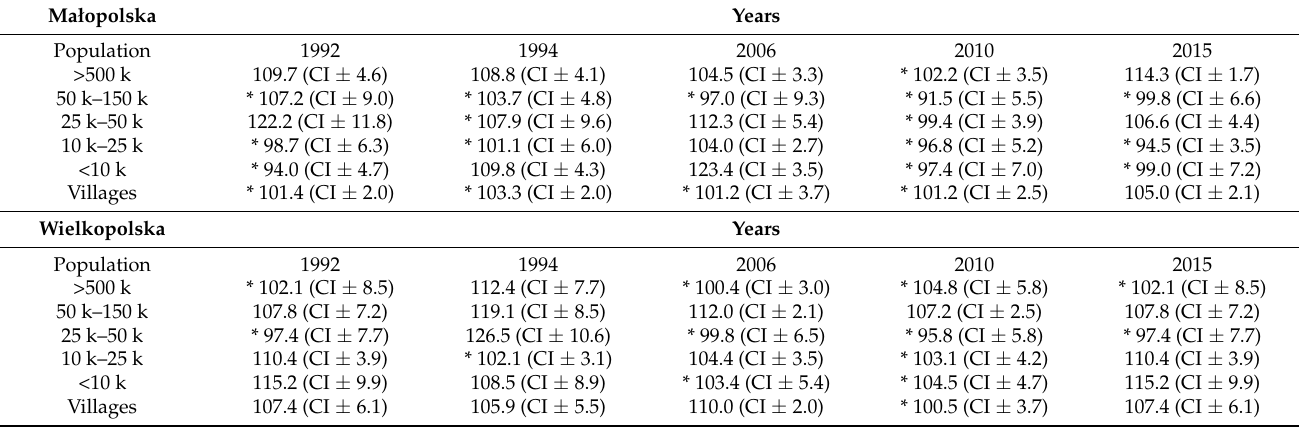
Table 5. Mortality from cardiovascular diseases during heatwaves calculated as percentage of the expected number of deaths. The period between the first sub-wave and the thirtieth day after the end of the last sub-wave. The 90% confidence intervals are in brackets. Statistically insignificant results are marked with